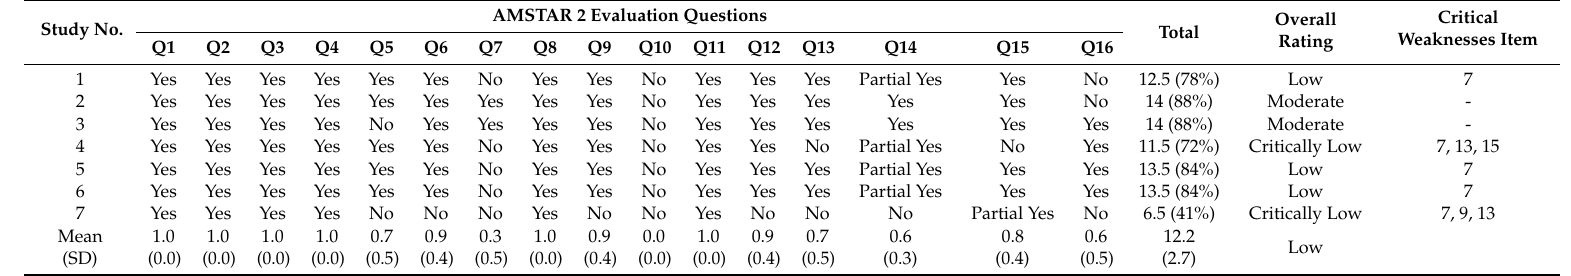
Table 5. Quality evaluation using AMSTAR